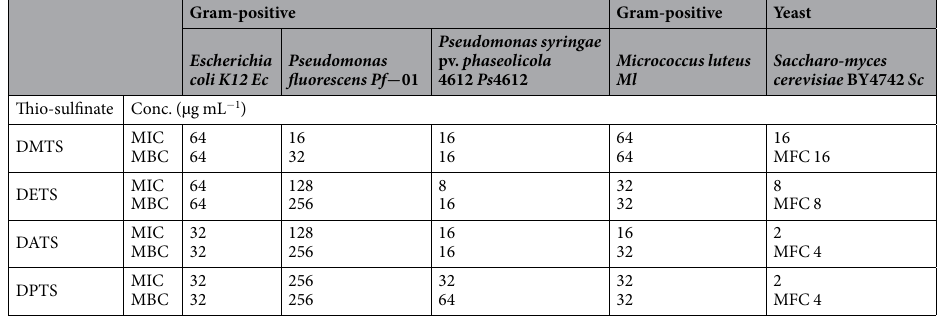
Table 1. MIC and MBC values ( µ g mL − 1 ) for the different thiosulfinates in the bacteria tested and MIC and MFC for yeast. The values are given as the highest value out of three